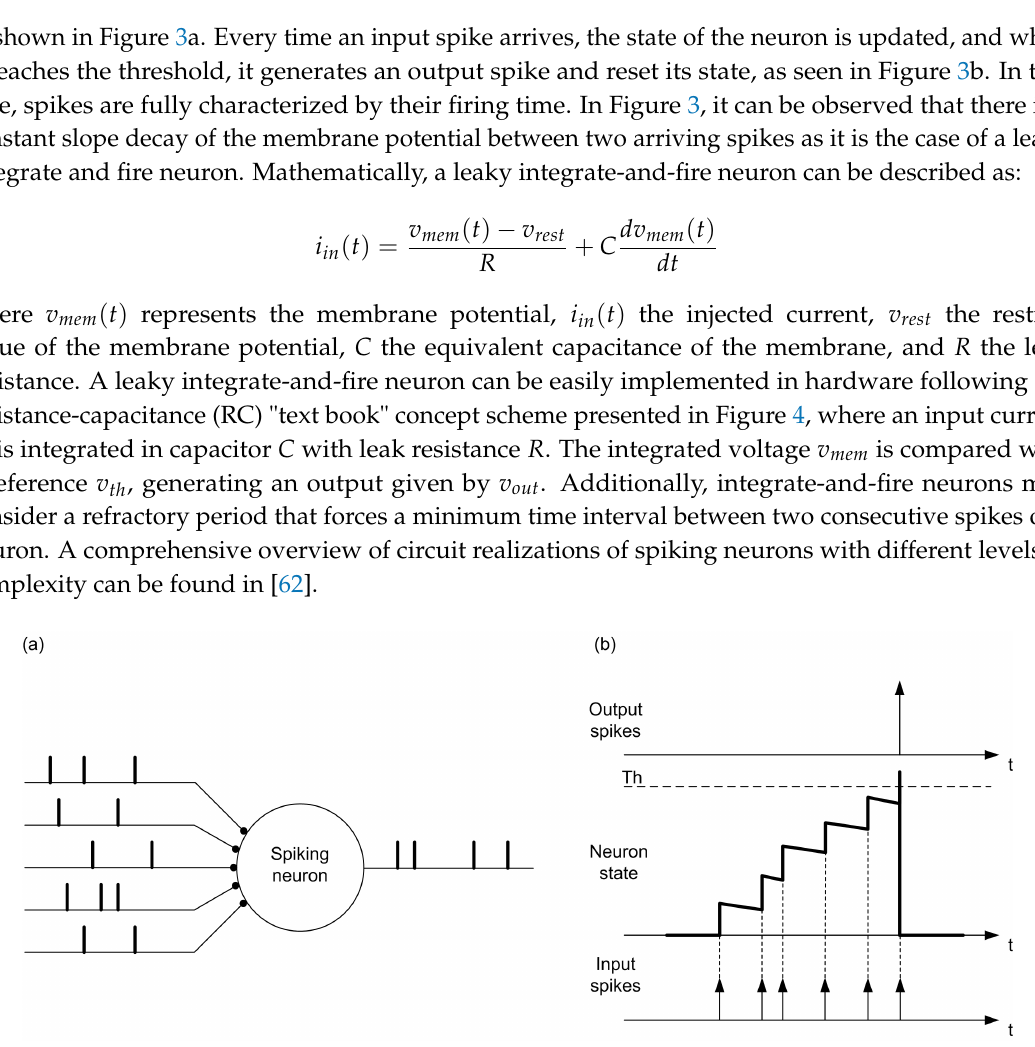
Figure 3. Illustration of the behavior of a leaky integrate-and-fire spiking neuron. ( a ) A spiking neuron receives spikes from several inputs, processes them, and generates output spikes from its output node. ( b ) Temporal evolution of the neuron state while it receives input spikes. When the threshold is reached,